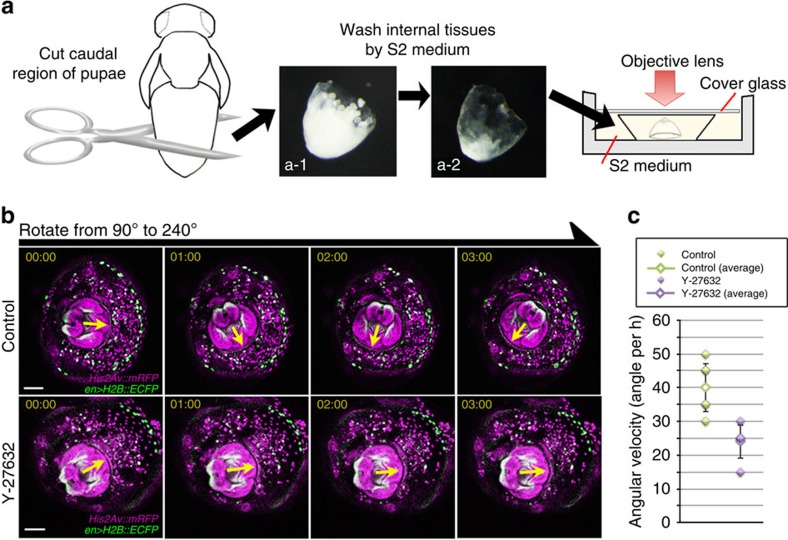
The autonomous epithelial movement is involved in genitalia rotation.(a) Schematic of the ex vivo culture experiment. The excised caudal region of pupae (a-1) was cleaned of internal tissues by pipetting with S2 medium (a-2), then placed into a culture tray with S2 medium. Time-lapse images were captured by a microscope. (b) Genitalia rotation occurred in the ex vivo-cultured genital disc (upper). The rotation was impaired by Y-27632 treatment (lower). Green: nuclei in the posterior of each segment, visualized by ECFP in the nucleus driven by en-GAL4. Magenta: His2Av::mRFP. Scale bar, 100 μm. (c) Graph showing the angular velocity of the ex vivo-cultured genital disc rotation, calculated for 2 h after the beginning of ex vivo culture. Error bars indicate s.d. Fly genotypes: en-GAL4 UAS-H2B::ECFP/+; His2Av::mRFP/+ (a,b).